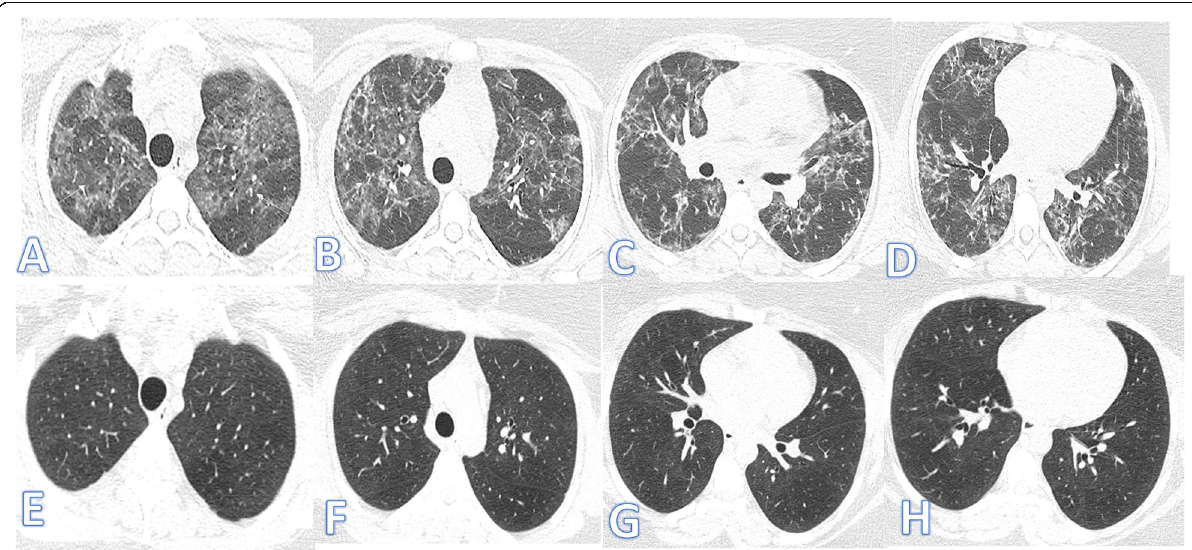
Fig. 5 Thirty-year-old female: she has no previous medical illness; CT severity score 15; consolidation/crazy-paving score 10. No ICU admission; laboratory results showed normal lymphocyte and serum ferritin, high CRP, D -dimer. Steroid was given; length of stay during hospitalization is 14 days. Peak CT during admission ( a – d ) showed bilateral central and peripheral GGO mainly in the upper lobes, associated with lung fibrosis with parenchymal bands and coarse reticular pattern (arrows). Follow-up CT 2 months after discharge ( e – h ) showed total resolution of the previous lung